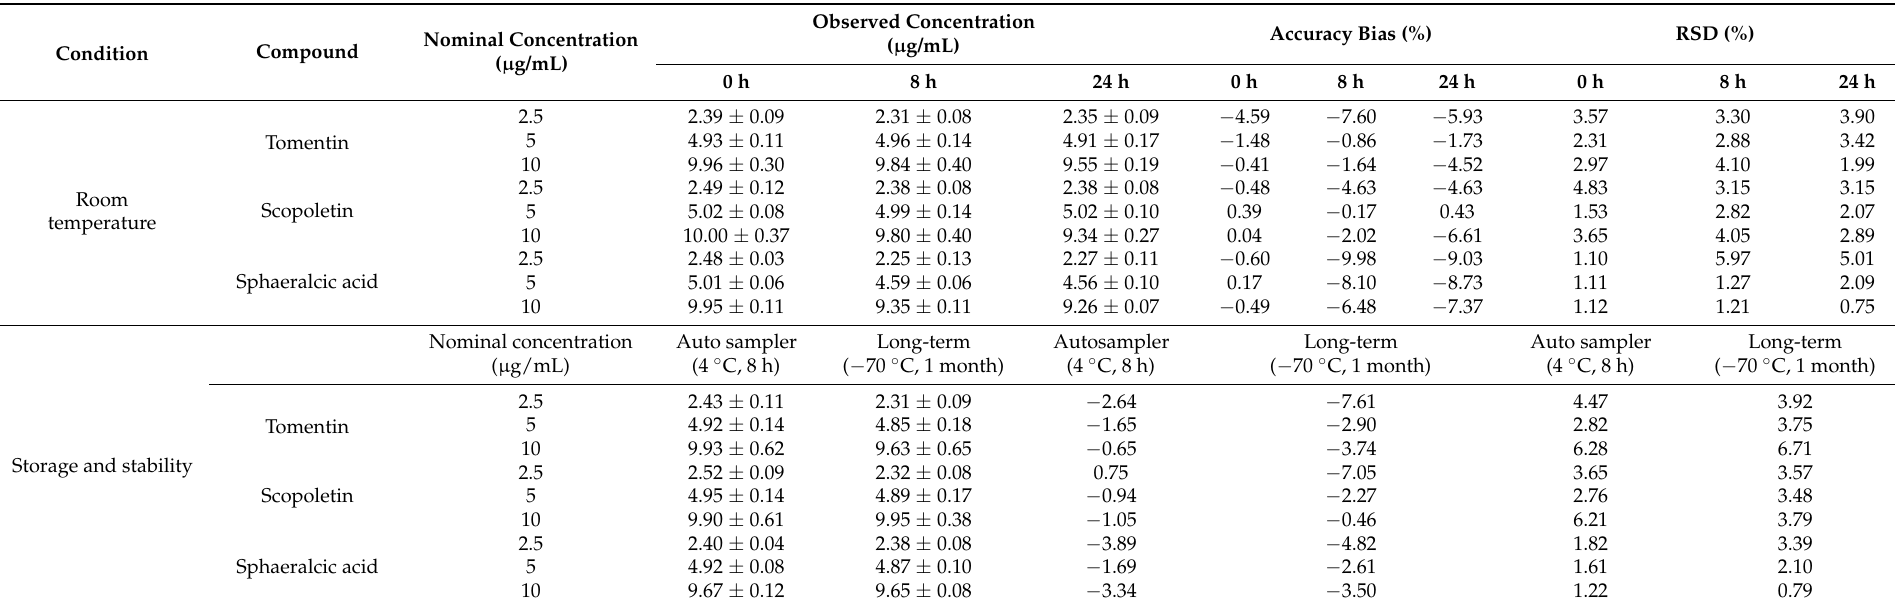
Table 2. Stability profile of active compounds tomentin, scopoletin, and sphaeralcic acid contained in the SaTSS fraction from Sphaeralceae angustifolia cell suspension in mice plasma (matrix) under different handling